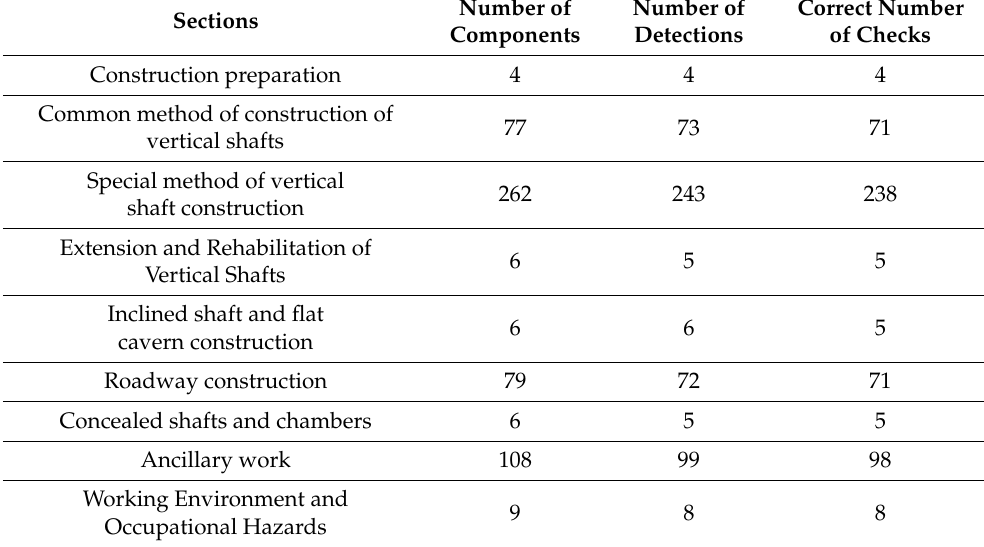
Table 5. System test results.